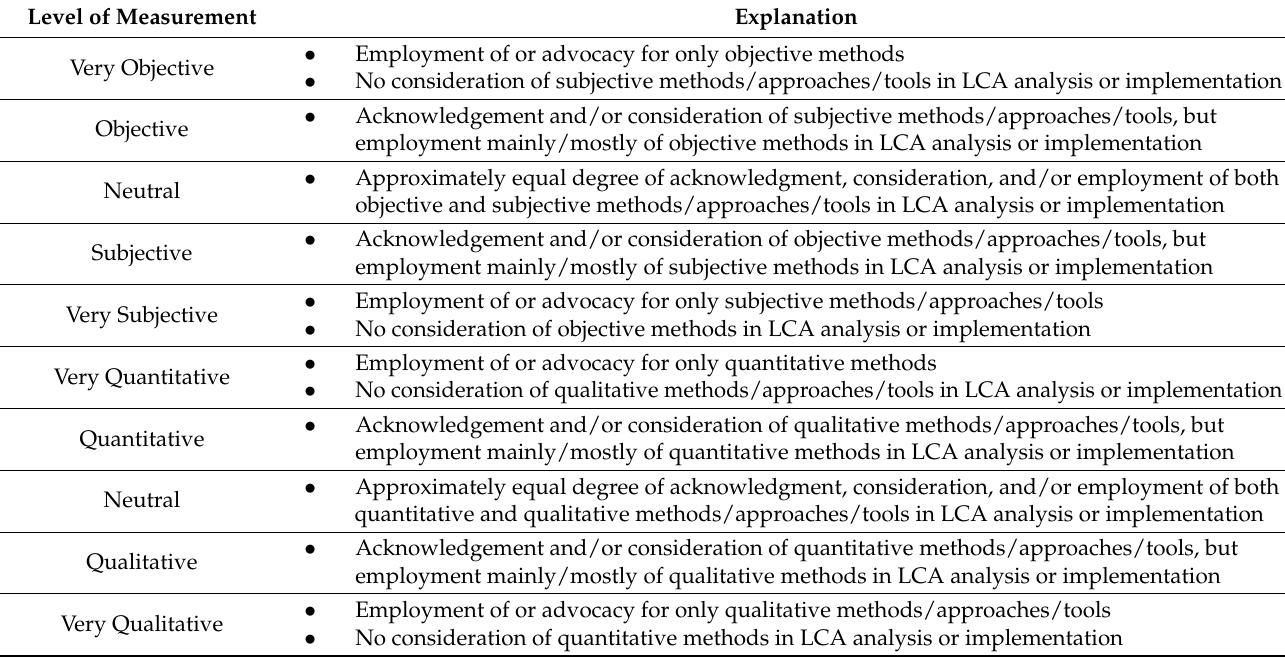
Figure 1. The conceptual model. The axes of the 2-variable scheme. Table 2. The 2-variable scheme and explanation of levels of